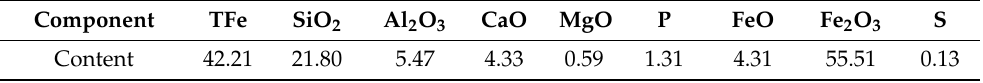
Table 1. Chemical element analysis of high phosphorus oolitic hematite ore (mass %).